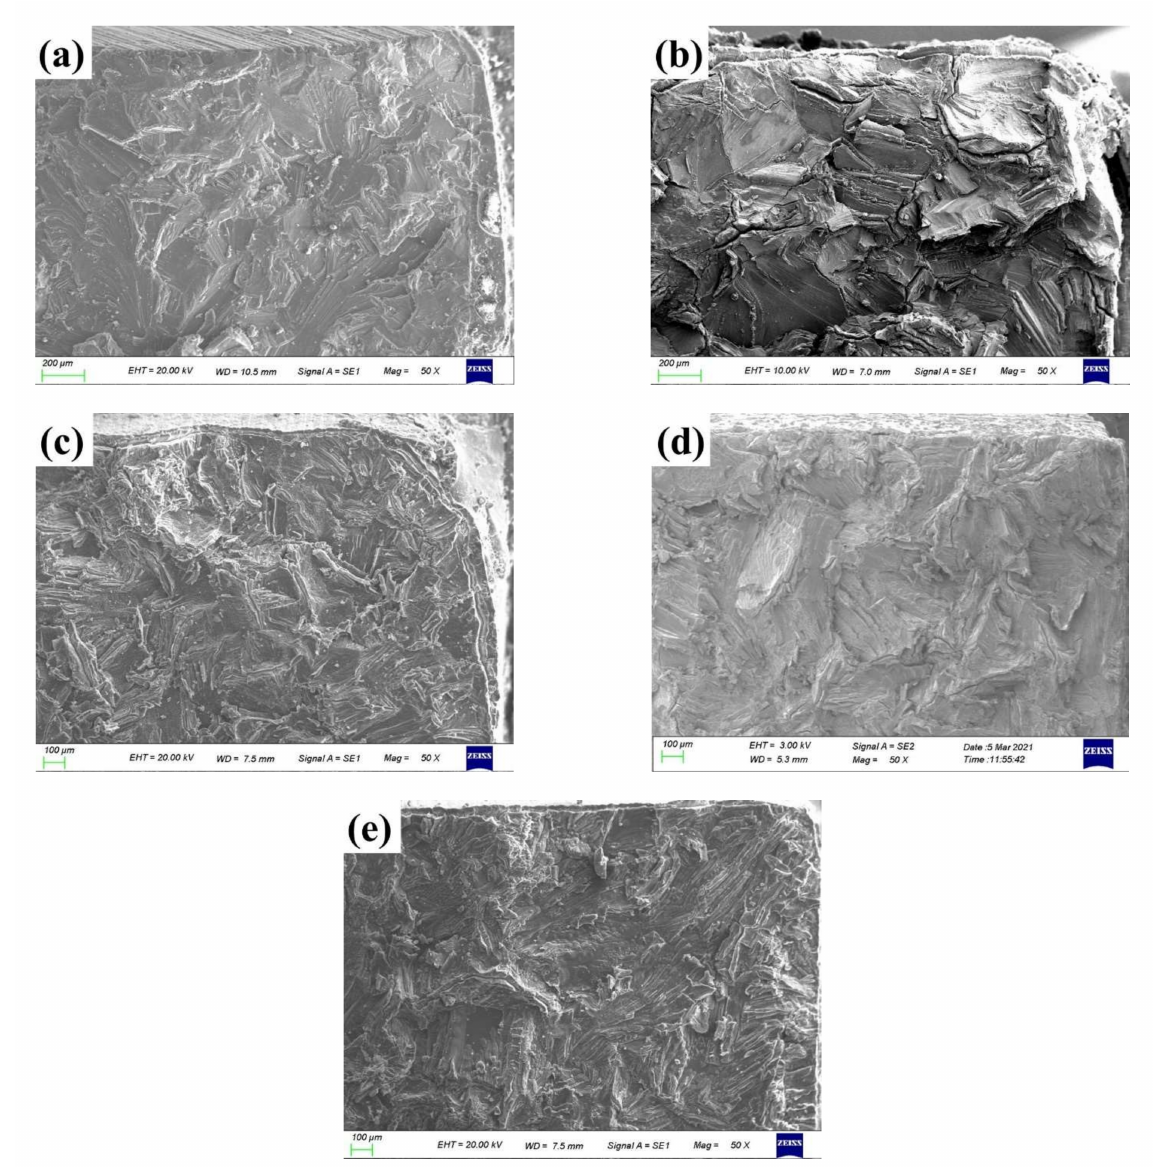
Figure 5. Fracture surfaces of tensile specimens for LiH at: ( a ) RT; ( b ) 200 ◦ C; ( c ) 300 ◦ C; ( d ) 400 ◦ C; ( e ) 500 ◦